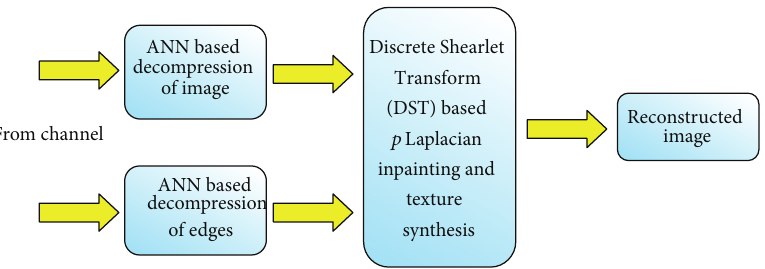
Figure 2: Block diagram of proposed image compression scheme–decoder.